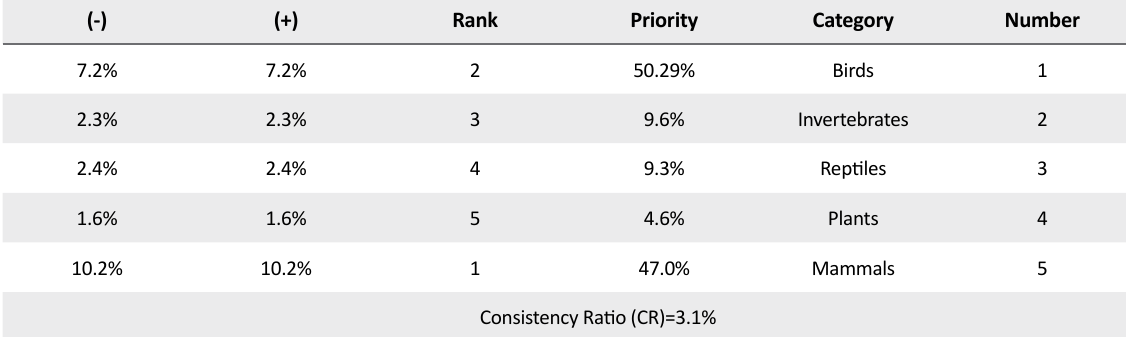
Table 2. Weight of biological resources sub-criteria NumberCategoryPriorityRank(+)(-)